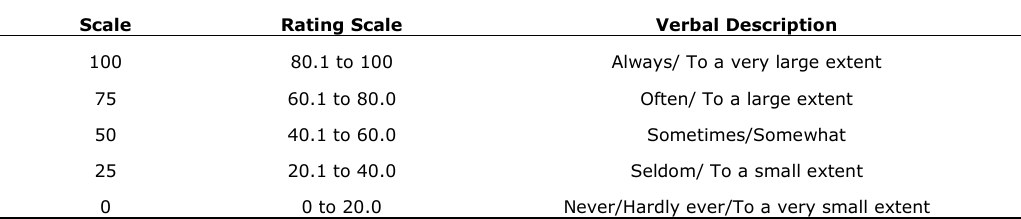
Table 4. Description of scale of the psychosocial health among off-shore workers